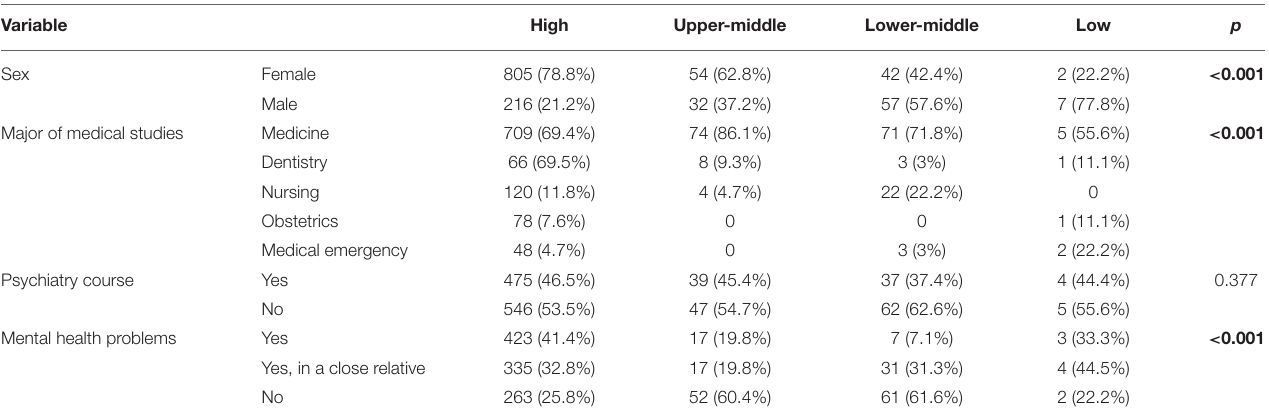
TABLE 3 | Characteristics of the study group considering GDP per capita.